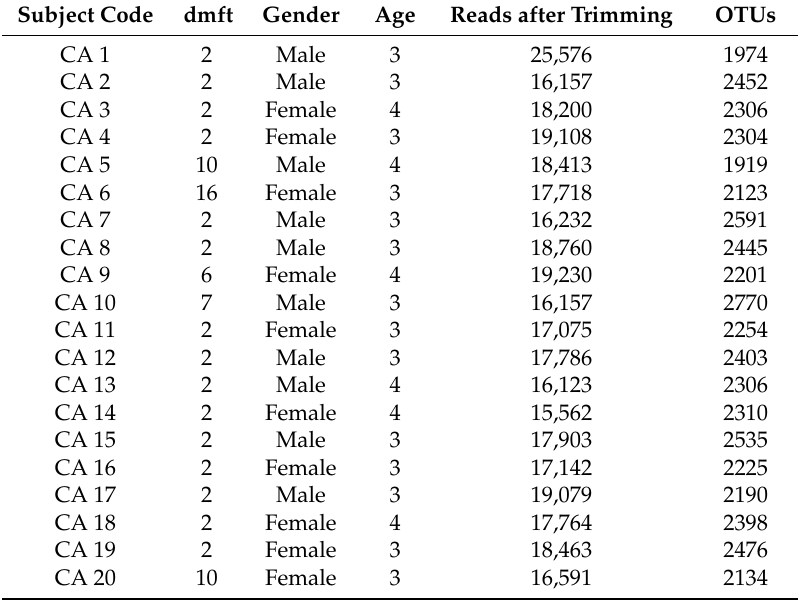
Table 1. Sequences of individual saliva samples of the caries-affected (CA) and caries-free (CF)